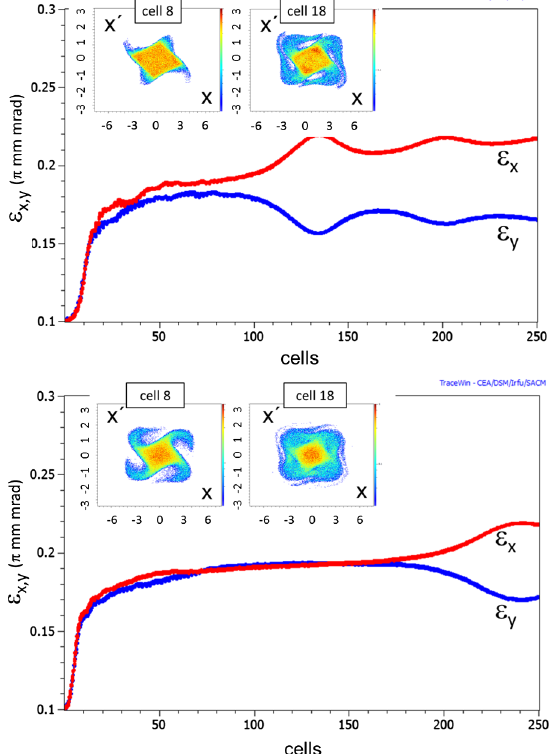
FIG. 4. rms emittances versus cell number for k 0 ;x;y ¼ 120 °, k ¼ 80 ° (inserts showing phase space plots at indicated cells) x;y for KV beam (top graph) and for waterbag distribution beam (bottom graph).